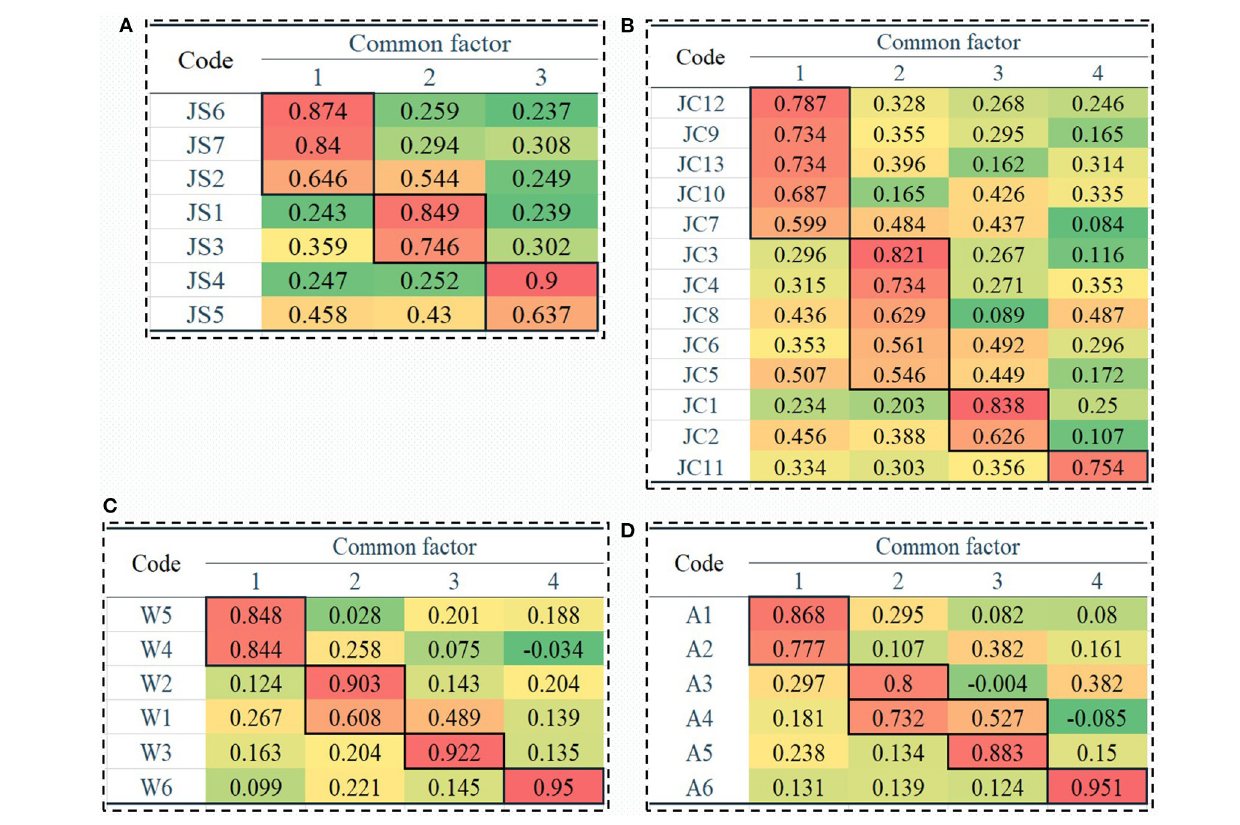
FIGURE2 The matrix of common factor load values for each fatigue-influencing factor in the “work” dimension. Extraction method: principal component analysis; Rotation method: Kaiser normal maximum variance method. The common factor matrix after the above rotation: (B, D) are the convergent rotations after 5 iterations; (A, C) indicate that the rotation has converged after 7 iterations.